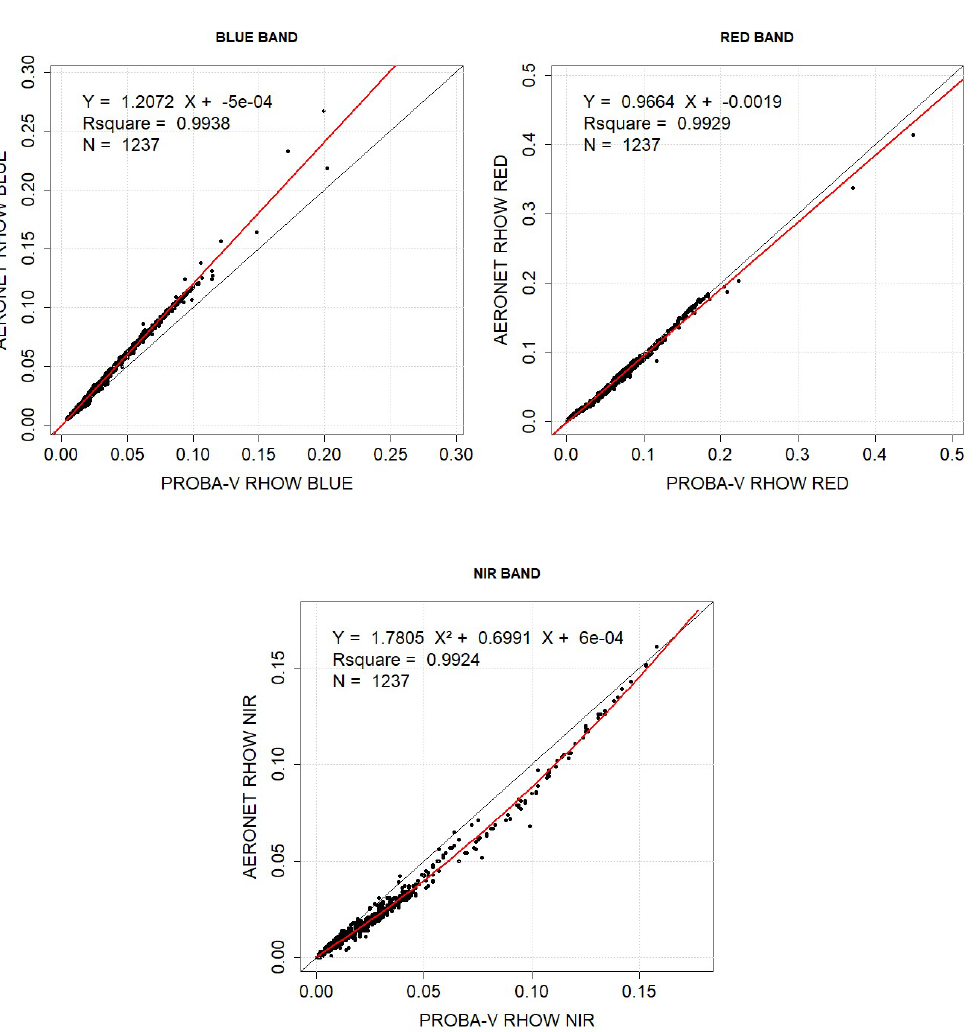
Figure 4. Scatterplots of simulated ρ w from PROBA-V versus AERONET at selected center wavelengths. The determination coefficient (r²) and the slope characterize the linear regression for the BLUE and RED band. For the near infrared (NIR) band a polynomial fit is used.